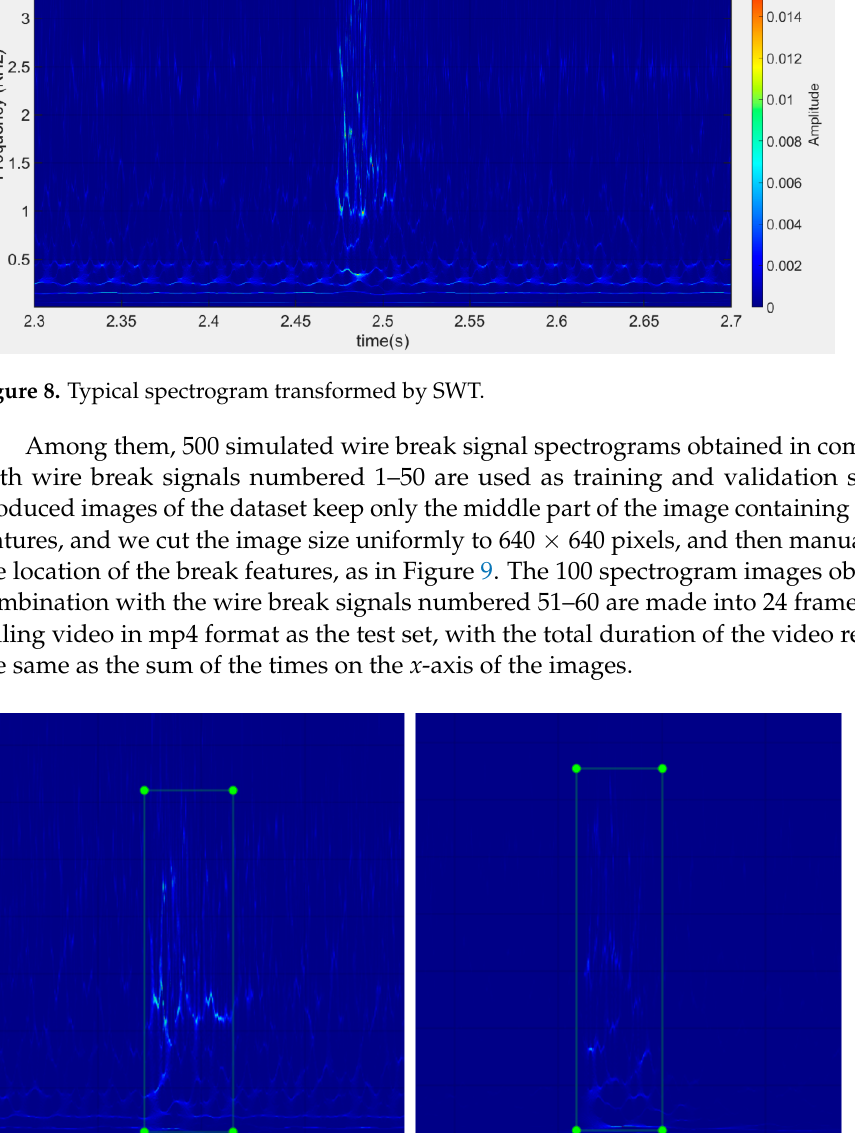
Figure 7. Typical acoustic signal combination processes.